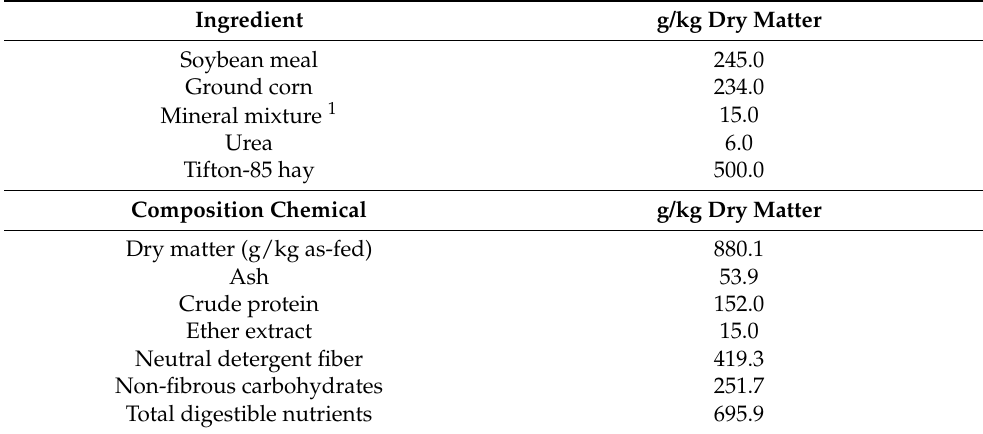
Table 1. Proportion of ingredients and chemical composition of experimental diet. Ingredient g/kg Dry Matter Soybean meal 245.0 Ground corn 234.0 Mineral mixture 1 15.0 Urea 6.0 Tifton-85 hay 500.0 Composition Chemical g/kg Dry Matter Dry matter (g/kg as-fed) 880.1 Ash 53.9 Crude protein